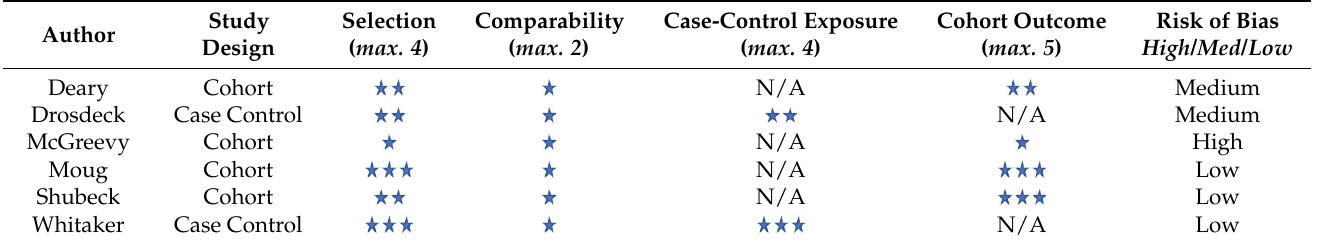
Table 4. Newcastle-Ottawa scale for risk of bias